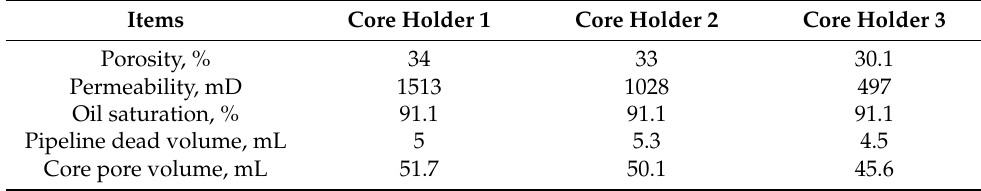
Table 2. Parameters of 3-tube coreflooding